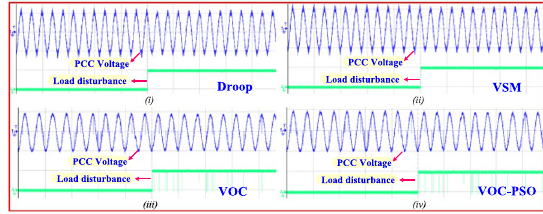
Fig. 24 Terminal voltage [Ch-1: PCC voltage, Ch-4: Load disturbance], (i) Droop control (ii) VSM (iii) VOC and (iv) VOC-PSO; [ Ch -1, 2, and 3: 10 V/div and Ch -4: 1 V/div]